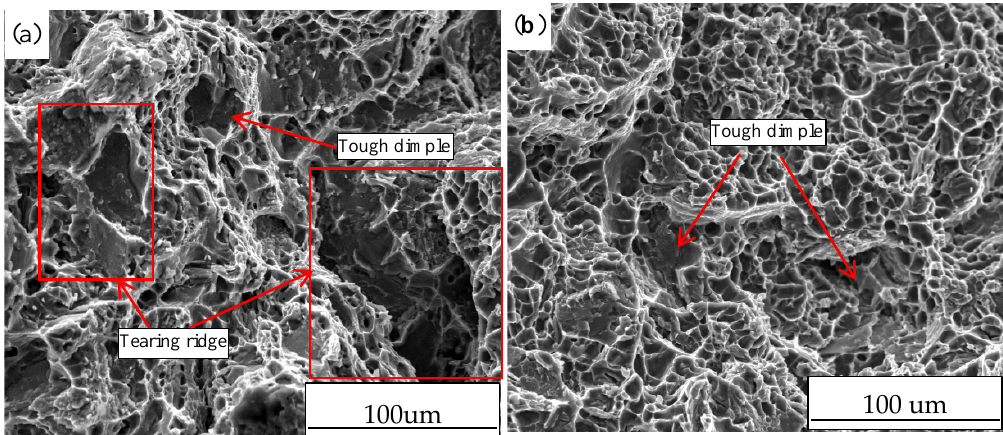
Figure 9. The tensile fracture morphology of vacuum counter-pressure casting samples; ( a ) without UST, ( b ) with UST.